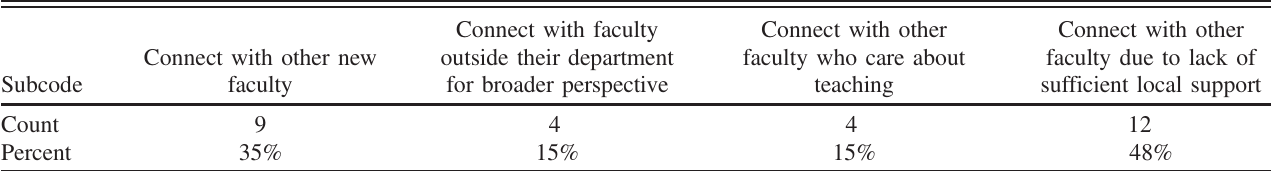
TABLE IV. The subcodes of the motivation to “ expand professional community. ” People could fall into more than one category. Count represents the number of participants coded to a category. Percentages are out of the 25 participants who joined the FOLC to expand their professional